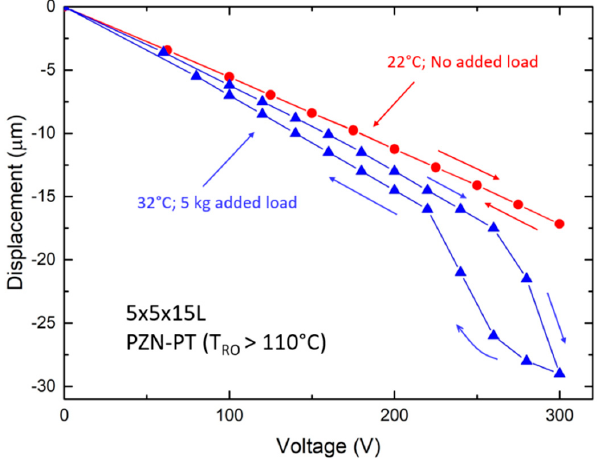
Figure 4. Typical displacement-voltage responses of stake actuators under unipolar drive conditions.